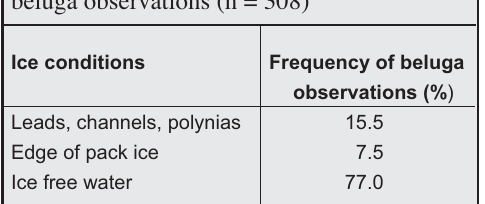
Table 4. Ice age at the locations of beluga